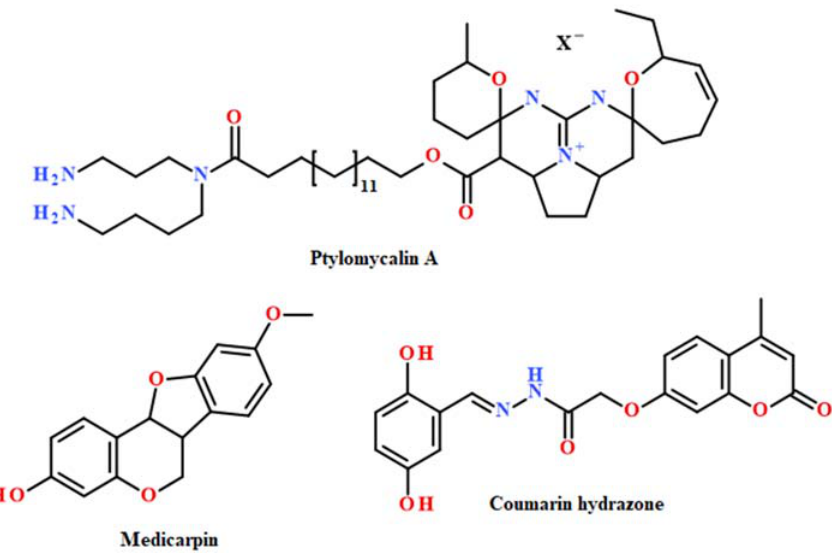
Figure 1. Structures of laccase inhibitors: ptylomycalin A, medicarpin, and coumarin hydrazone.